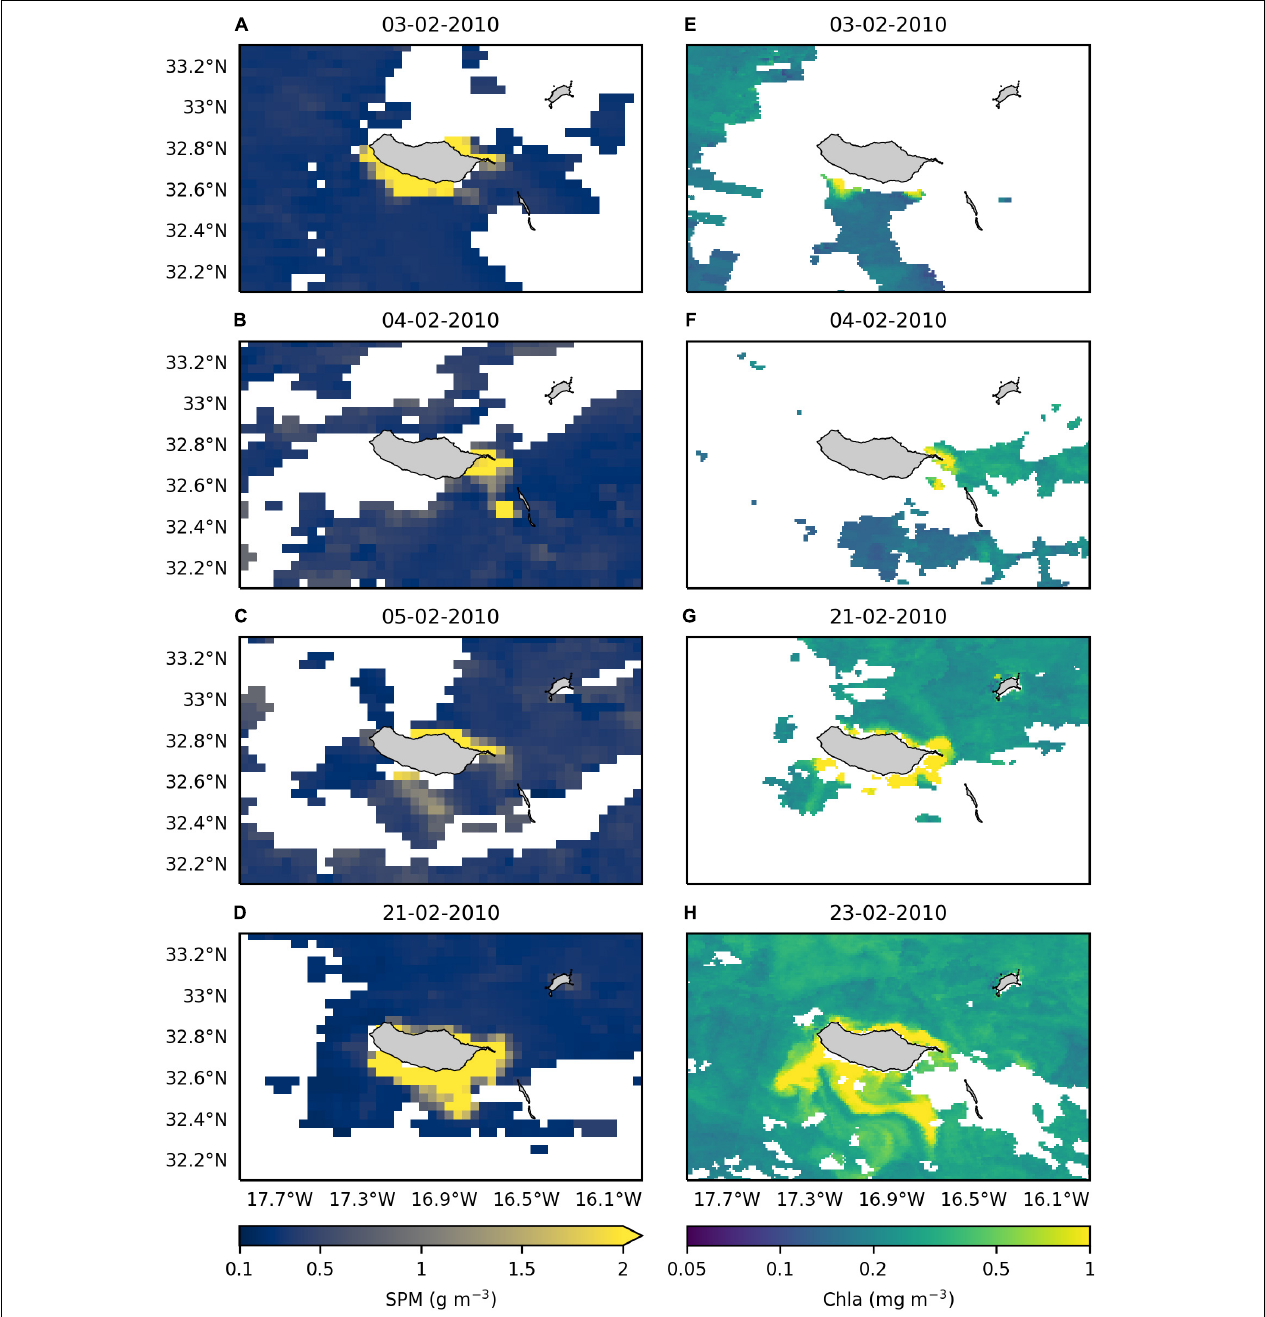
FIGURE 2 | Satellite images of the regional area of Madeira Archipelago. Daily averages of (A–D) non-algal Suspended Particulate Matter (SPM; g m − 3 ) and (E–H) Chlorophyll-a (Chla; mg m − 3 ) concentrations for specific days of February 2010.